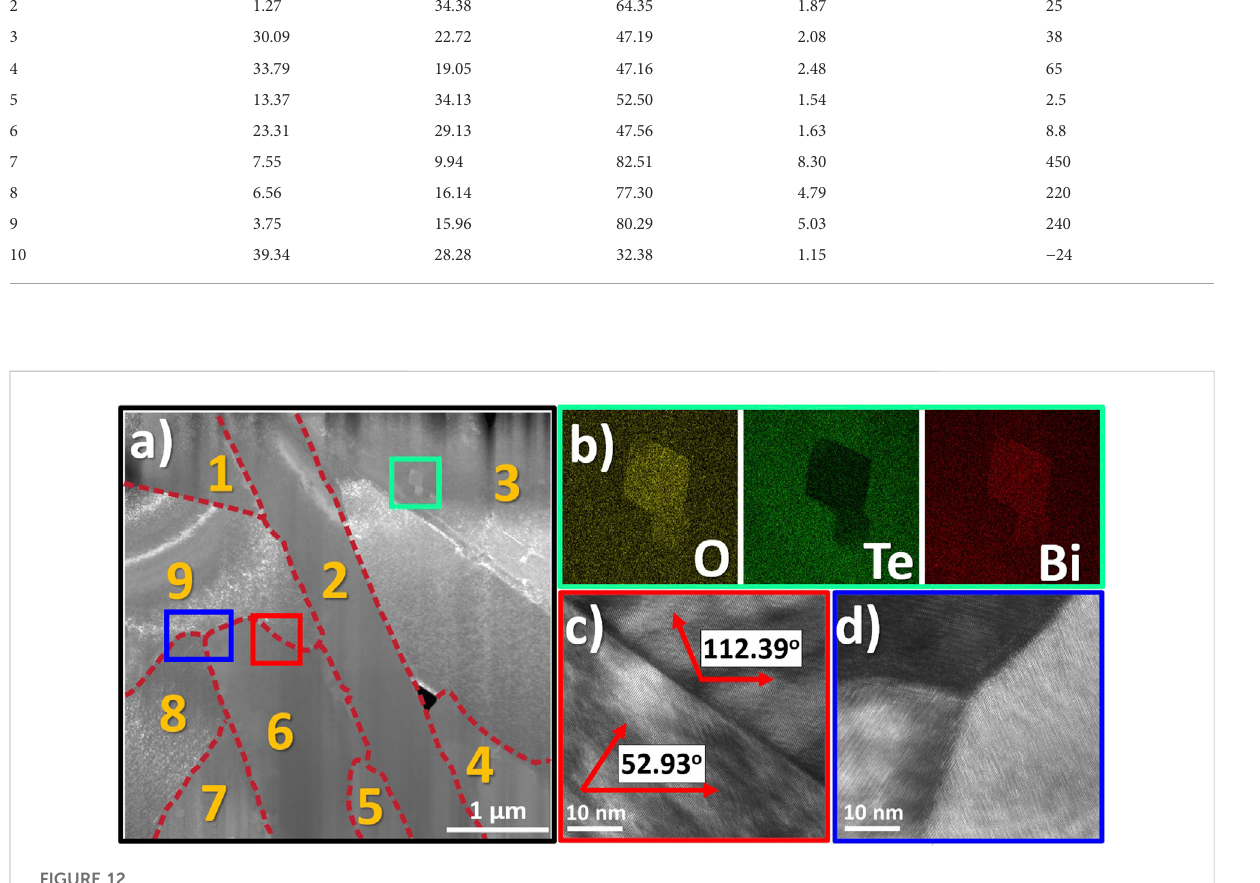
FIGURE 12 Transmission electron microscopy images of laser processed Bi 2 Te 3 : (A) High grain and dislocation density in the microstructure, (B) Te-de fi cient region with bismuth oxide inclusion, (C – D) Difference in crystal orientations that can result in localized strain fi